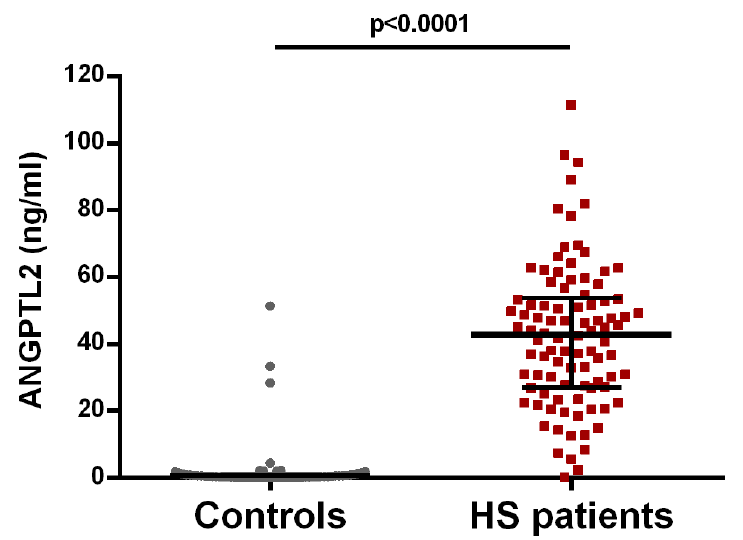
Figure 1. Serum ANGPTL2 levels in HS patients and controls. Median and 25 and 75 interquartile ranges are represented. Significant differences were observed ( p < 0.0001).